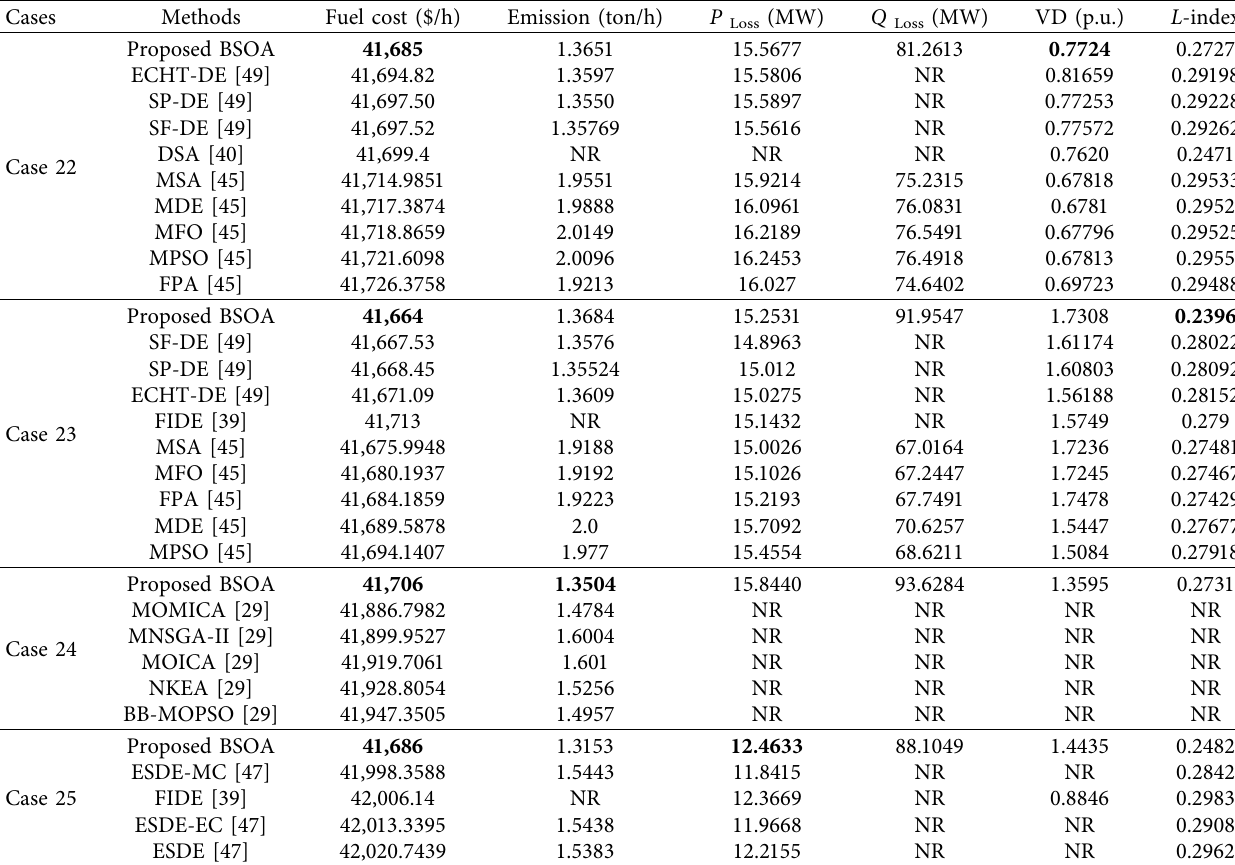
Table 11: Comparison of proposed BSOA with previous recent studies of biobjective cases (case 22 to case 25) for the IEEE 57-bus system. Cases Methods